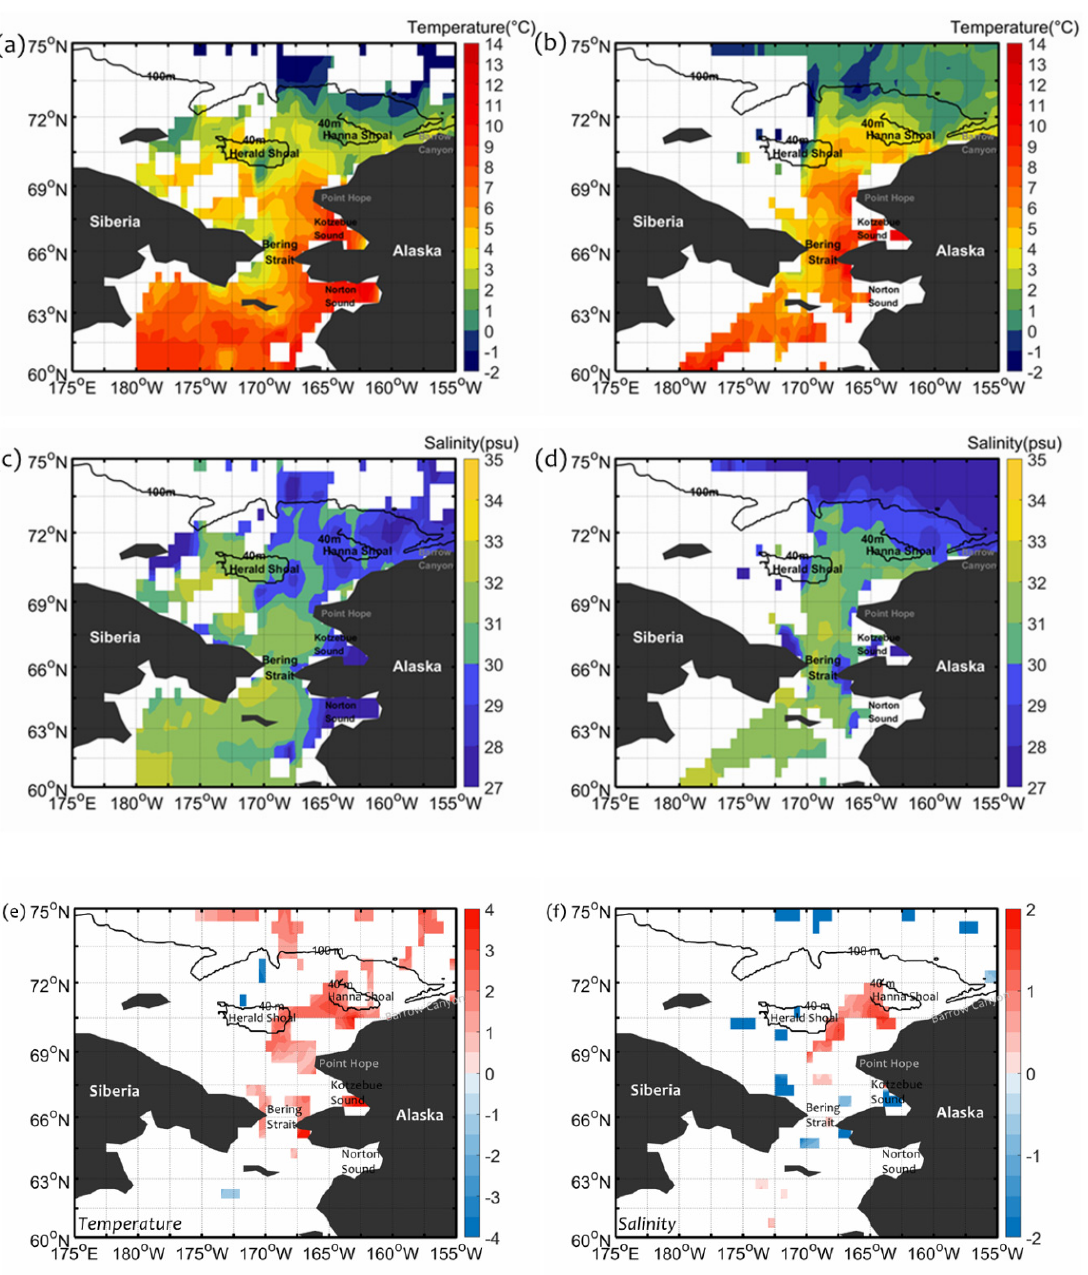
Figure 10. Surface temperature of ( a ) pre-1997 and ( b ) post-1997 periods, and ( c , d ) for salinity; differences in ( e ) surface temperature and ( f ) surface salinity between the two periods. The solid black contours represent 100 m and 40 m isobaths.